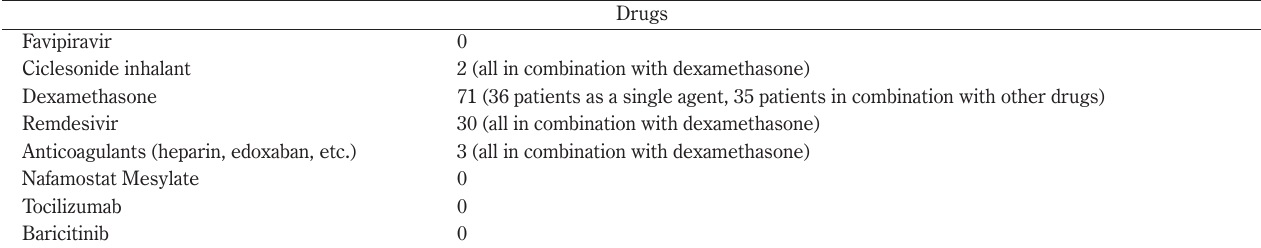
Table 5 Drug treatments of COVID-19